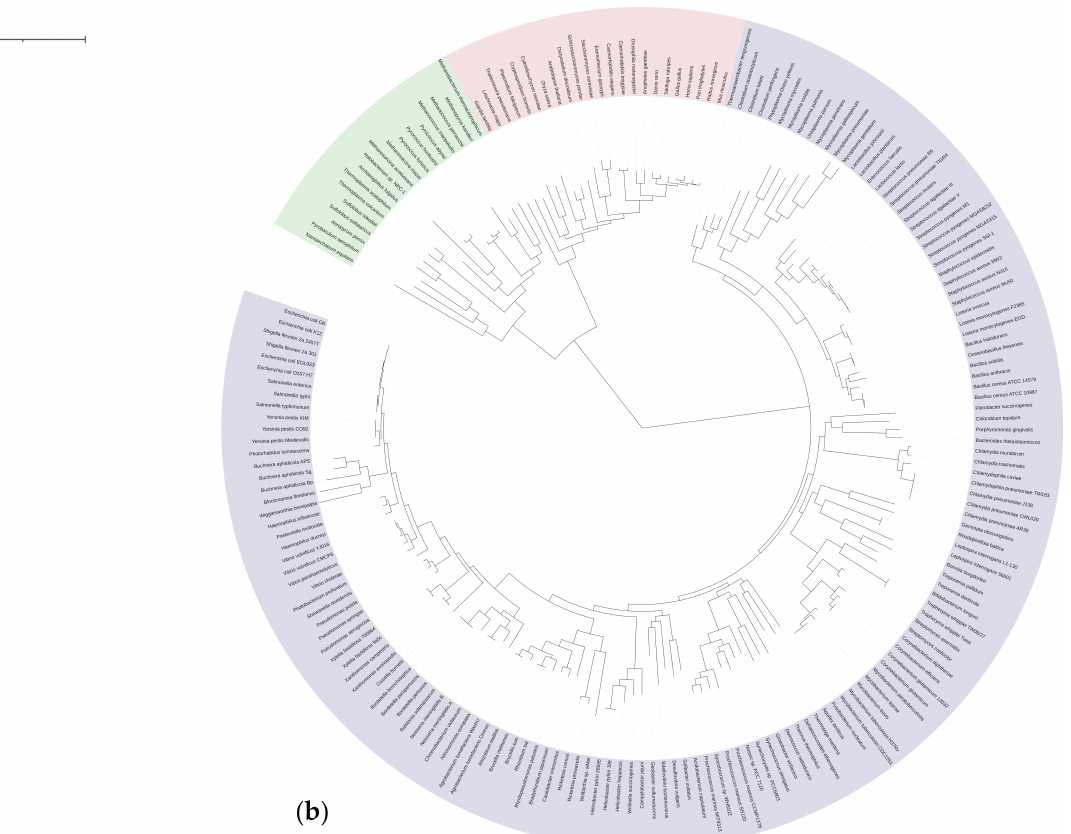
Figure 5. ( a ) Alpha diversity measurements relative to various statistical thresholds. Beta diversity refers to the ratio between local or alpha diversity and regional diversity. This is the diversity of species between two habitats or regions. The relationship between species and genomes is identified by the phylogenetic tree of life. The centre displays the last universal ancestor of all life on earth. The three domains of life are shown by different colours: pink represents eukaryota (animals, plants and fungi); blue represents bacteria; and green represents archaea. Taxonomic clades of six samples spanning from arid and semi-arid habitats showing the root clade. These figures are produced by iTOL and shown in Figure 5b [61]. ( b ) Taxonomic clades of six samples spanning from arid and semi- arid habitats showing the root clade [Color code: Bacteria-purple; Pink-Eukaryotes;